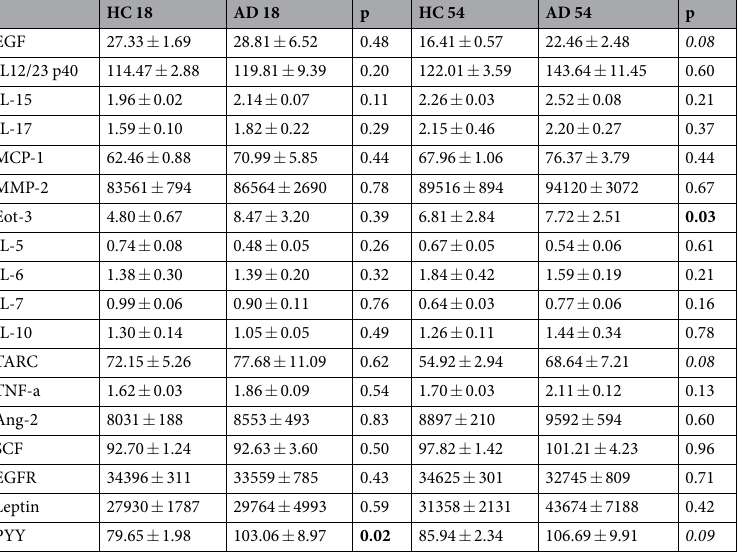
Table 3. General Linear Model analysis of the biomarkers in HC and AD at 18 and 54 month time points in non-converters only. Data are presented as Mean ± S.E., although statistical analysis was performed on the log 10 value to better approximate a normal distribution. For IL-5, IL-6 and IL-17 the log 10 conversion was performed on the (raw data + 1) in order to accommodate 0 values.